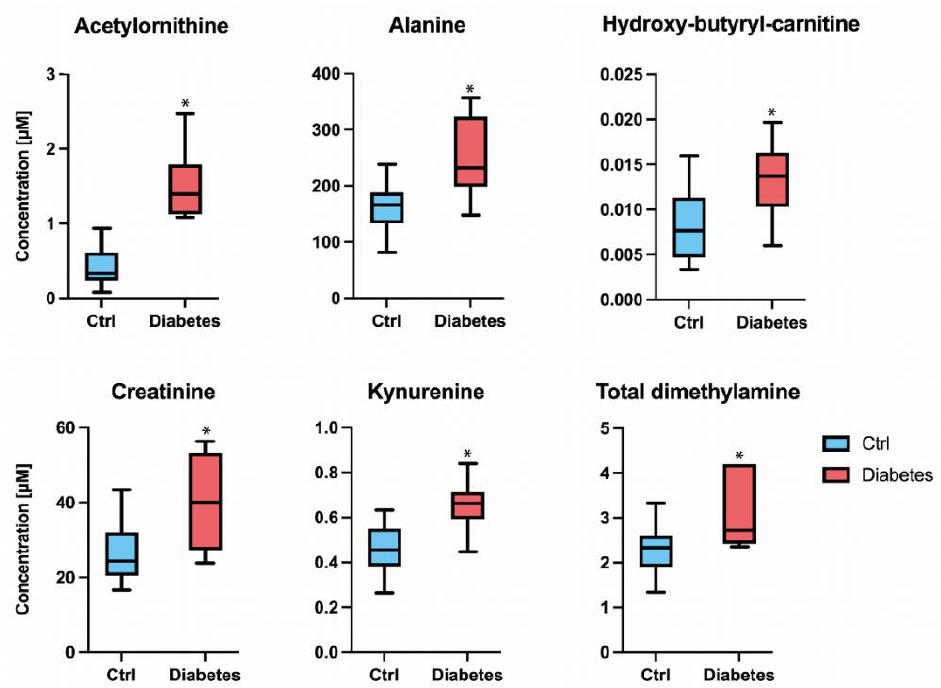
4 of 11 Table 2. Statistical correlations between the data from metabolites selected in the volcano plot. The Pearson coefficient is shown for pair-wise correlations. A total correlation would be defined by co- efficient = 1. * False Discovery Rate (FDR)-corrected < 0.05.